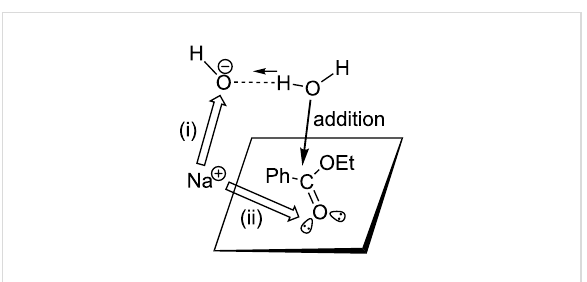
Figure 7: The effect of the counter ion Na + on TS1(es). When the pos- ition of Na + is near the nucleophile OH − in (i), its addition is deceler- ated. On the contrary, when it is near the carbonyl oxygen in (ii), the addition is accelerated owing to the enhancement of the elec- trophilicity of the carbonyl